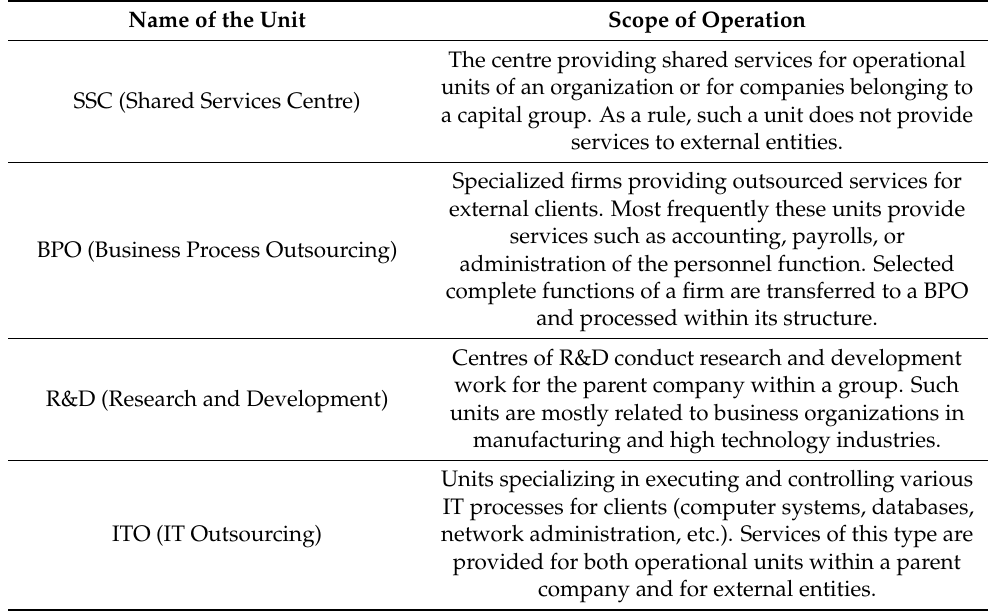
Table 3. Types and operational scope of shared services